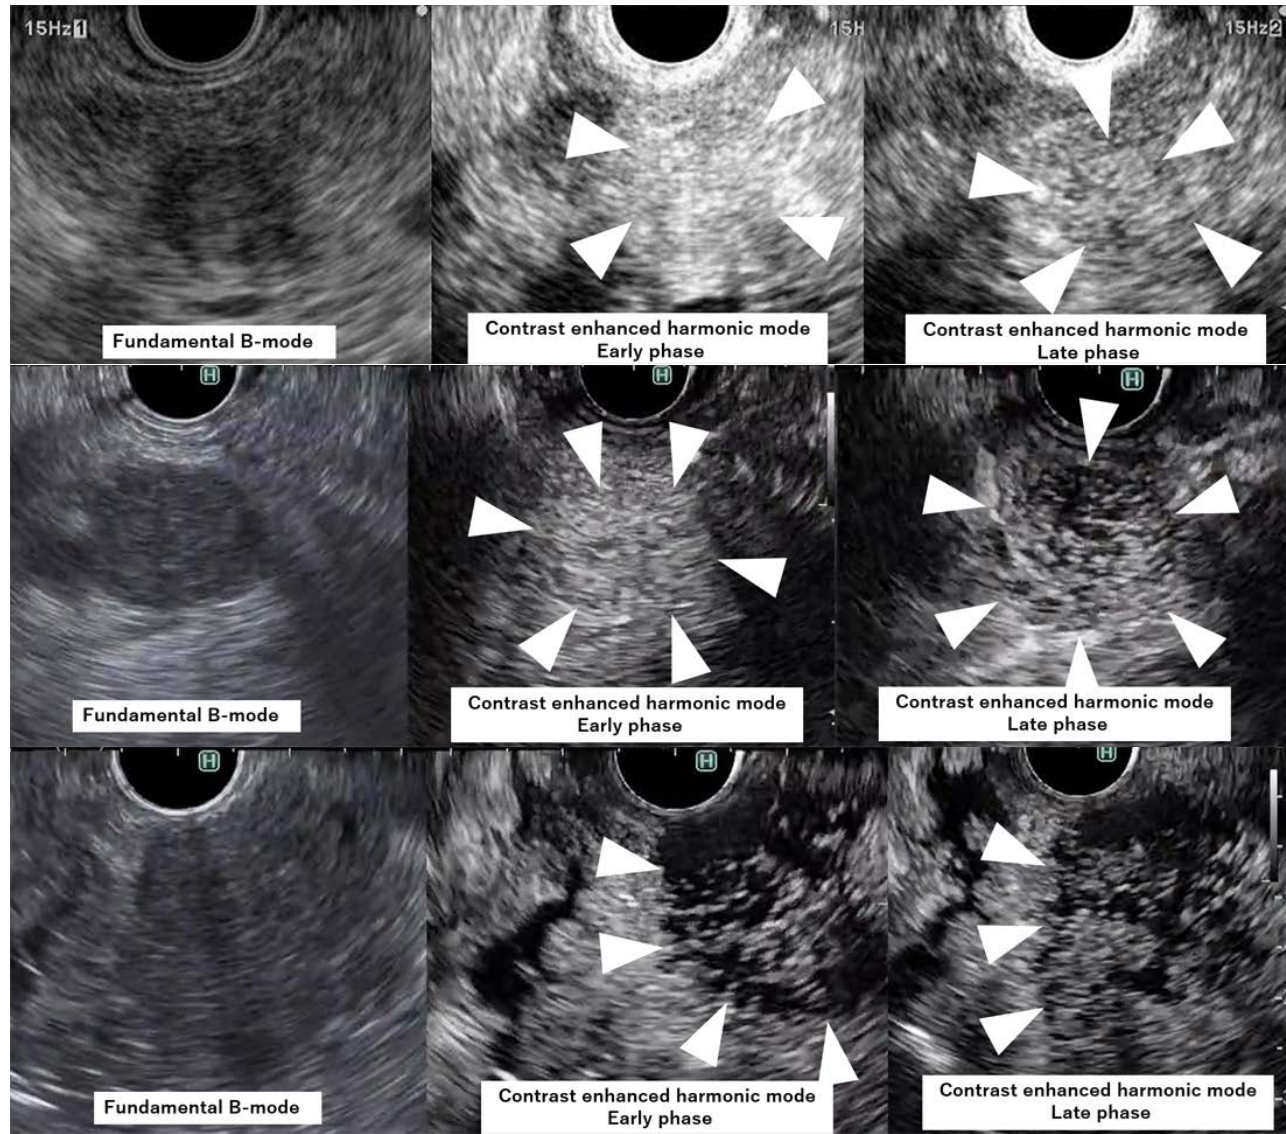
Figure 3. Evaluation of intratumoral vascularity on CH-EUS. A: Representative case from Group A showing a vascular-rich tumor in both phases. A pancreatic lesion was detected as a low-echoic lesion (arrowhead) on fundamental B-mode EUS (Pre). Intratumoral vascularity was evaluated as rich vascularity (arrowheads) on both early- (Early) and late-phase CH-EUS (Late). B: Representative case from Group B showing a vascular-rich and vascular-poor tumor in the early and late phases, respectively. A pancreatic lesion was detected as a low-echoic lesion (arrowheads) on FB-EUS (Pre). Intratumoral vascularity was evaluated as rich vascularity (arrowheads) on early-phase CH-EUS (Early) and poor vascularity (arrowheads) on late-phase CH-EUS (Late). C: Representative case from Group C showing a vascular-poor tumor in both phases. A pancreatic lesion was detected as a low-echoic lesion (arrowheads) on FB-EUS (Pre). Intratumoral vascularity was evaluated as poor vascularity (arrowheads) on both early- (Early) and late-phase CH-EUS